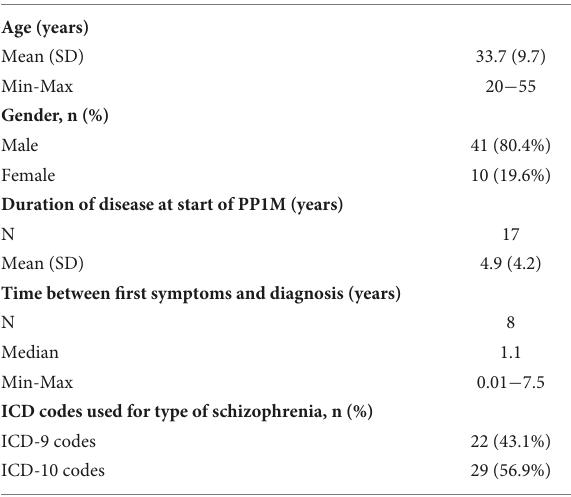
TABLE 1 Sociodemographic characteristics and disease history at the start of the observation